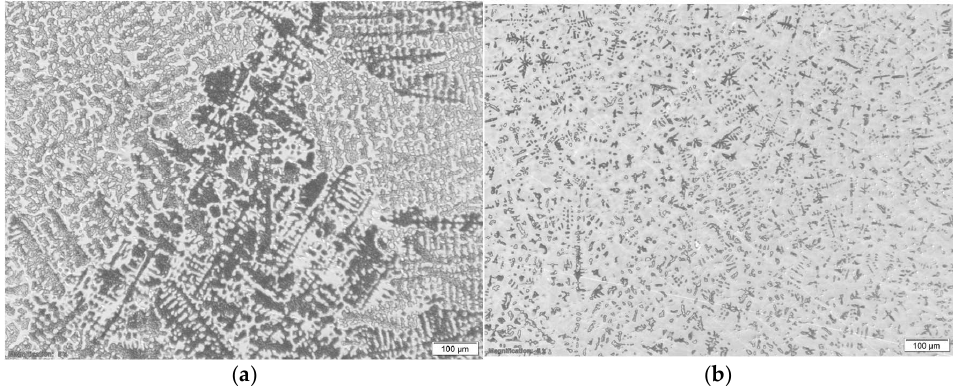
Figure 2. Initial microstructure of ( a ) Fe-30.9Mn-4.9Al-4.5Cr-0.4C; ( b ) Fe-21.3Mn-7.6Al-4.3Cr-1C.